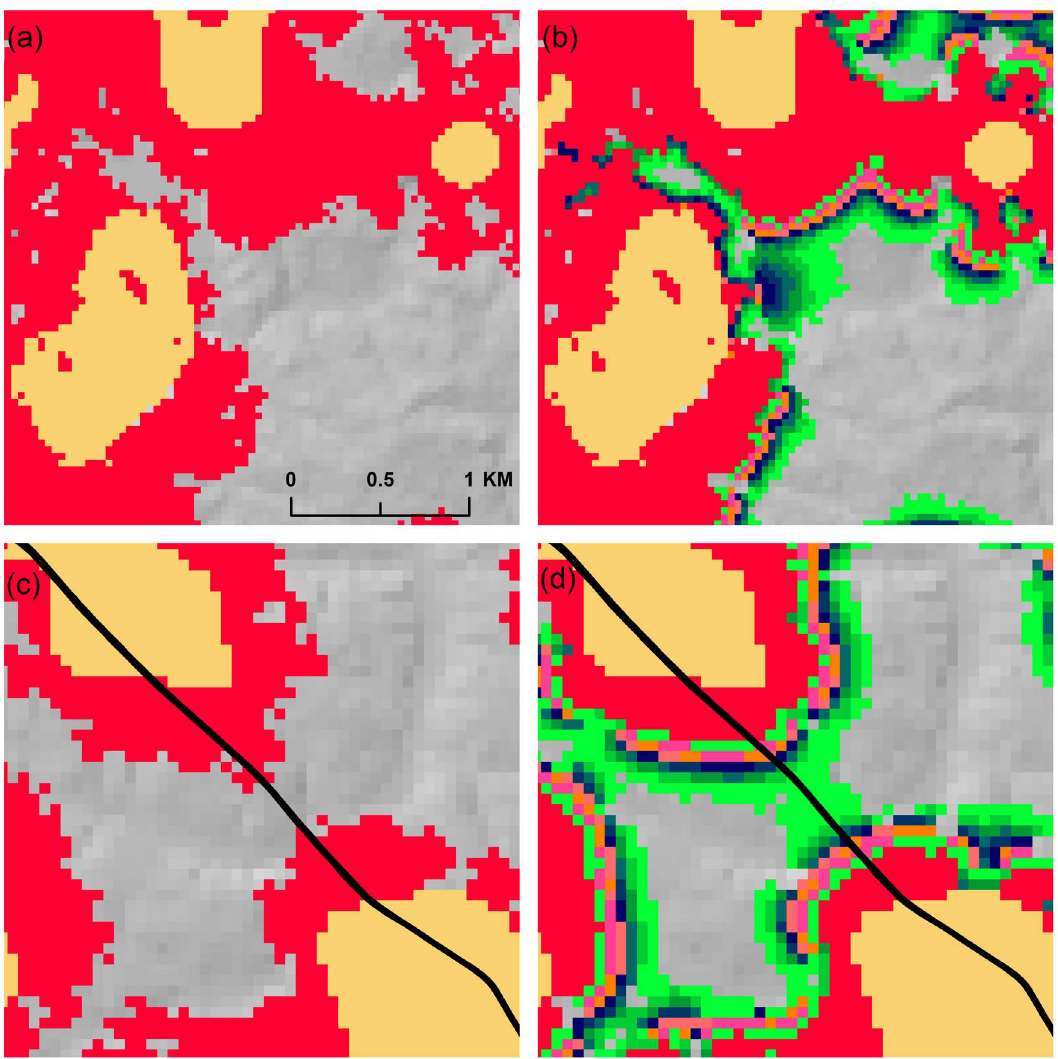
Figure 4. Examples of SLEUTH model output. Individual fifty-year model simulations (2010–2060) along with the final projection based on 200 Monte Carlo simulations for two fast-growing regions: Walton County in Georgia (Figure 4a and 4b) and Wake County in North Carolina (Figure 4c and 4d). Red cells in (a) and (c) correspond to new urban growth and gold cells depict 2009 classified urban areas. Cell colors in (b) and (d) are the same as color legend in Figure